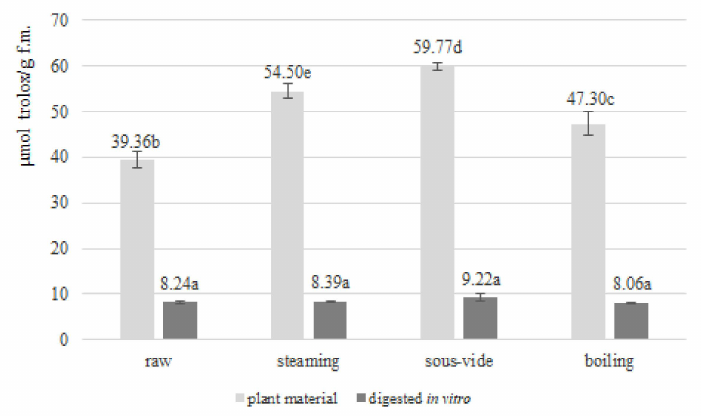
Figure 2. ABTS antioxidant activity ( µ mol trolox/g f.m.) in raw and thermally-treated Brussels sprouts before and after in vitro digestion. Means followed by the same letter (a,b,c,d,e) are not significantly different ( p ≤ 0.05); f.m.—fresh matter.